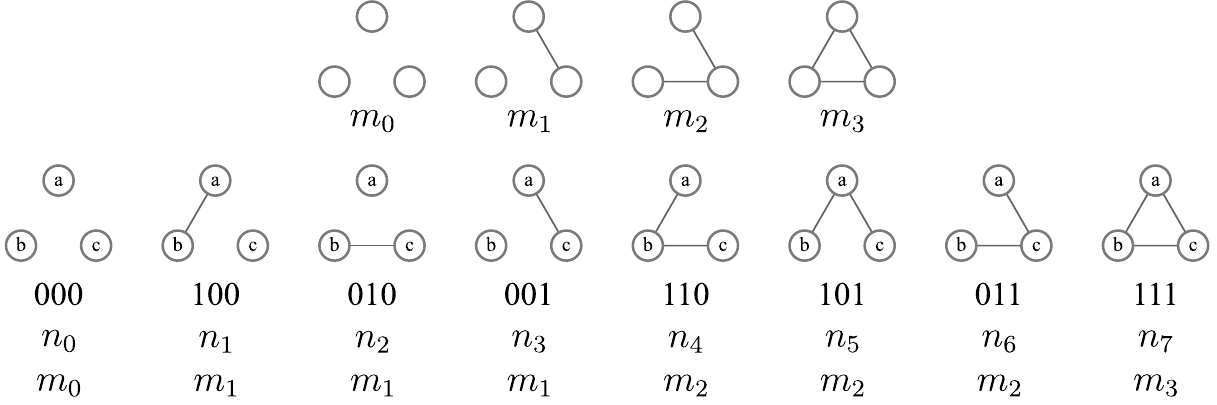
Figure 1. In the top row are the four triplet states of M 4 , used only for illustration in this paper. The four states m i ∈ M 4 ( i = 0, 1, 2, 3 ) are characterised by the number of links i in the given three-node graph. In the lower row, there are the eight distinct states of triplets when nodes are distinct (labelled). Below each labelled diagram is the binary representation of the edge set, the label n i ∈ M 8 ( i = 0, 1 . . . 7 ), and the corresponding m i triads if labels are